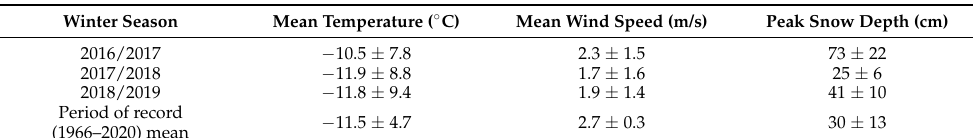
Table 1. Winter summary statistics with standard deviations at Barnaul weather station calculated from daily data [37].